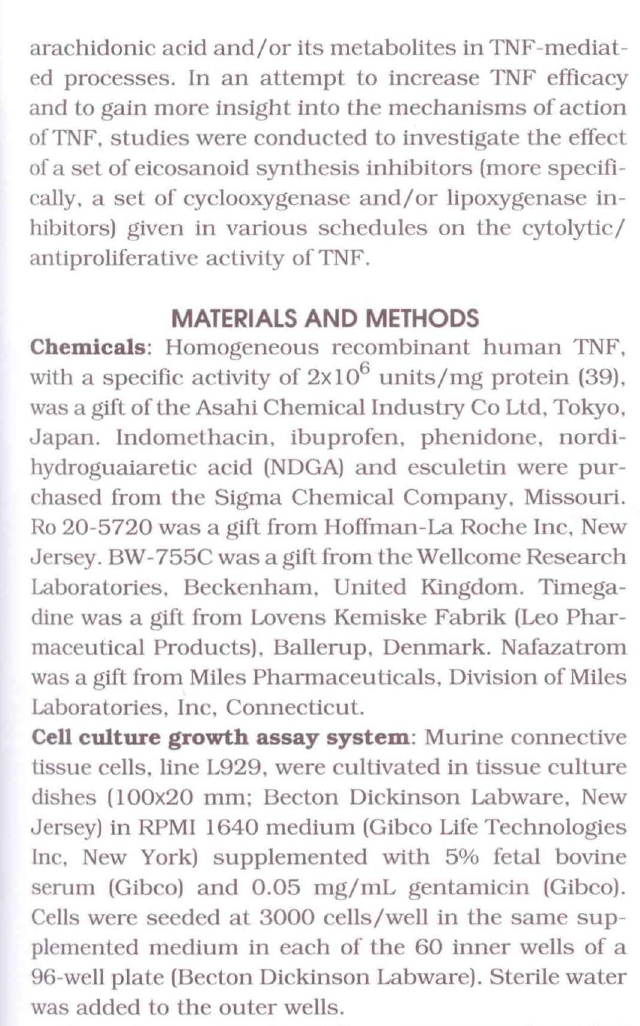
Figure 3) Schematic diagram of the five different schedules of drug administration used in this in vitro study. TNF Tumour necrosis